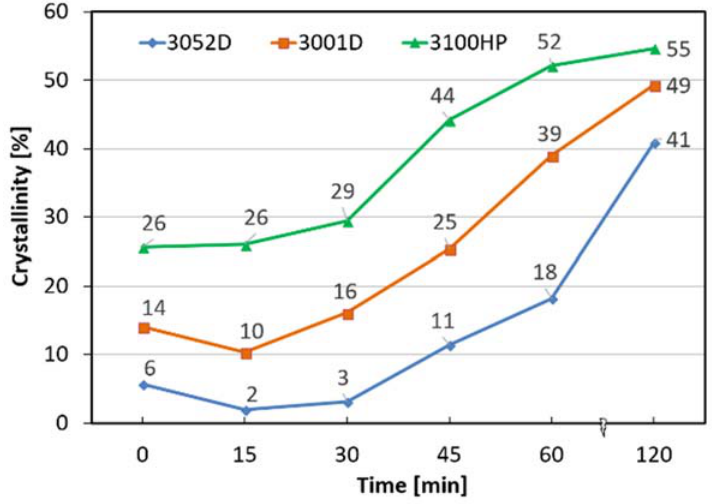
Figure 4. Crystallinity of PLA fibres as a function of annealing time.